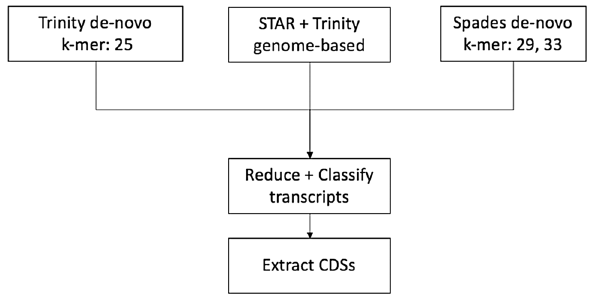
Figure 1. Overview of the main steps for predicting the B. mandrillaris proteome from RNA-seq reads using a hybrid approach. De-novo and genome-based assemblies are combined and processed with EviGene to reduce transcript redundancy and classify transcripts as encoding complete or incomplete protein coding sequences (CDSs, 5 ′ and/or 3 ′ truncated). CDSs are extracted, translated and annotated as “main” or alternate.